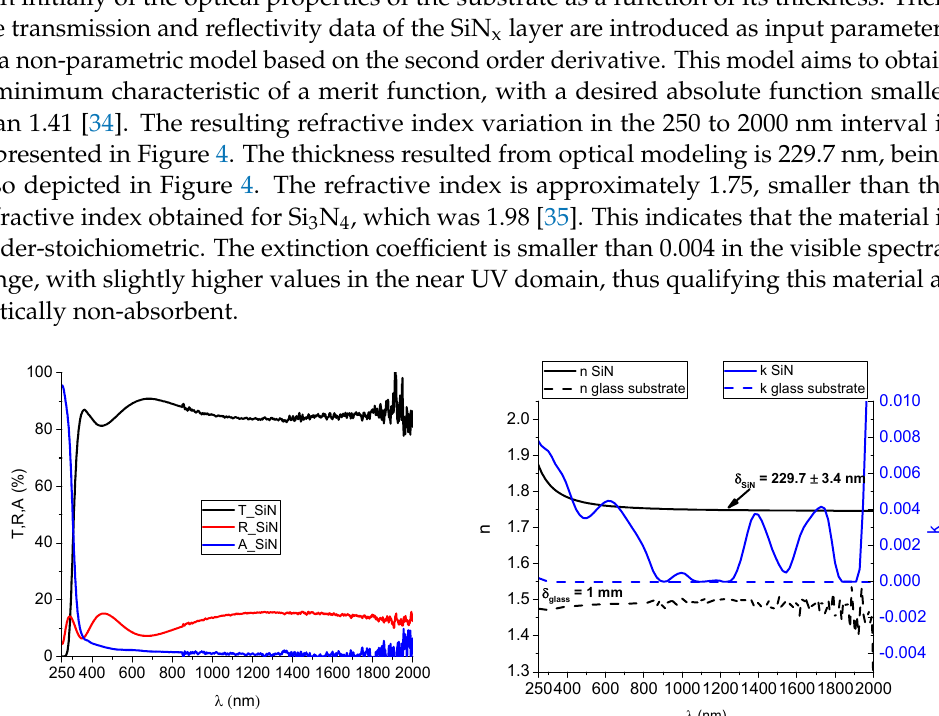
( b ) Figure 5. ( a ) Tauc plot for indirect band gap of SiN x monolayer with photon energy dependence of absorption coefficient (E 04 = f (h ν )—inset) and ( b ) FT-IR transmission spectrum of SiN x film.